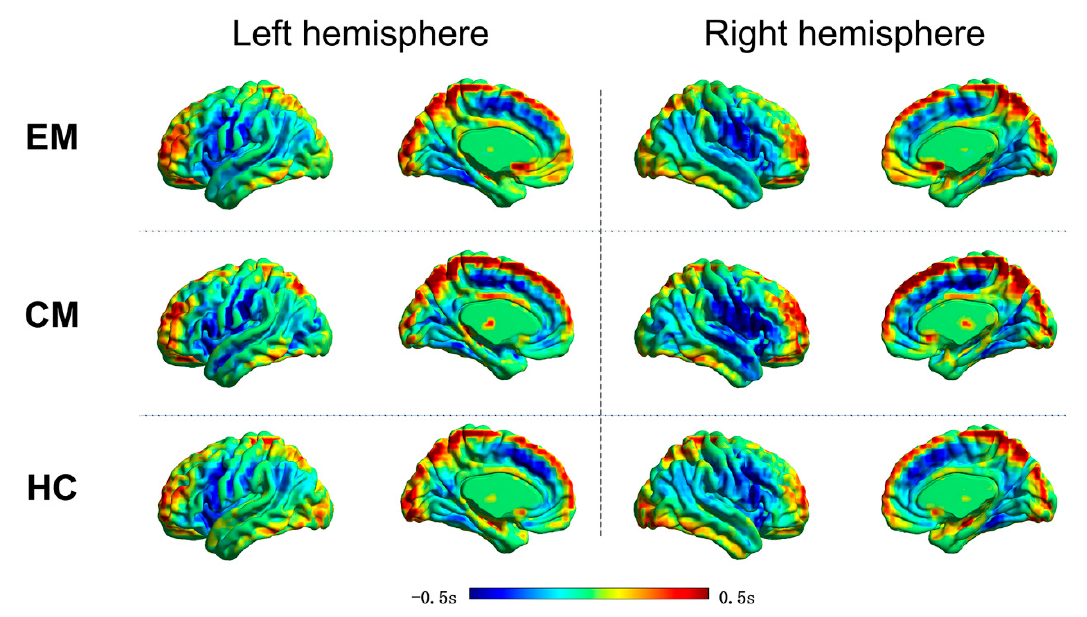
Figure 1. Temporal lag projection maps in the EM, CM, and HC groups. Warm color indicates brain areas in which intrinsic activity is temporally later, relative to that of the rest of the brain (positive seconds). Cool color indicates brain areas in which intrinsic activity is temporally earlier, relative to that of the rest of the brain (negative seconds). Apparent propagation of resting-state brain activity is measured on a time scale of ±0.5 s. EM, episodic migraine; CM, chronic migraine; HC, healthy control.